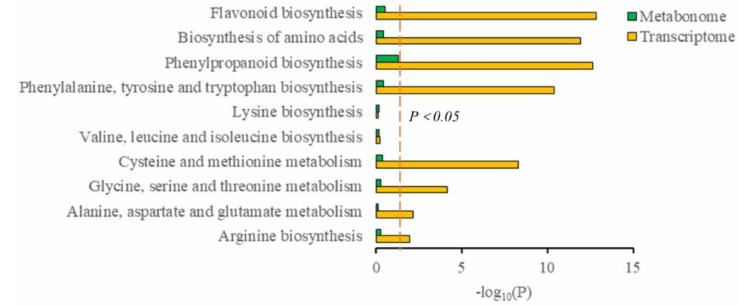
Figure 5. Histogram of the KEGG pathway enriched by the differentially expressed genes (DEGs) and metabolites between the two groups. Each post represents a pathway: orange shows the transcriptome, and green represents the metabolome. The ordinate represents pathway enrichment, and the abscissa represents the target pathway. The parameter “ p -value < 0.05” was used as the threshold to judge the significance of gene expression and the difference in the metabolites.